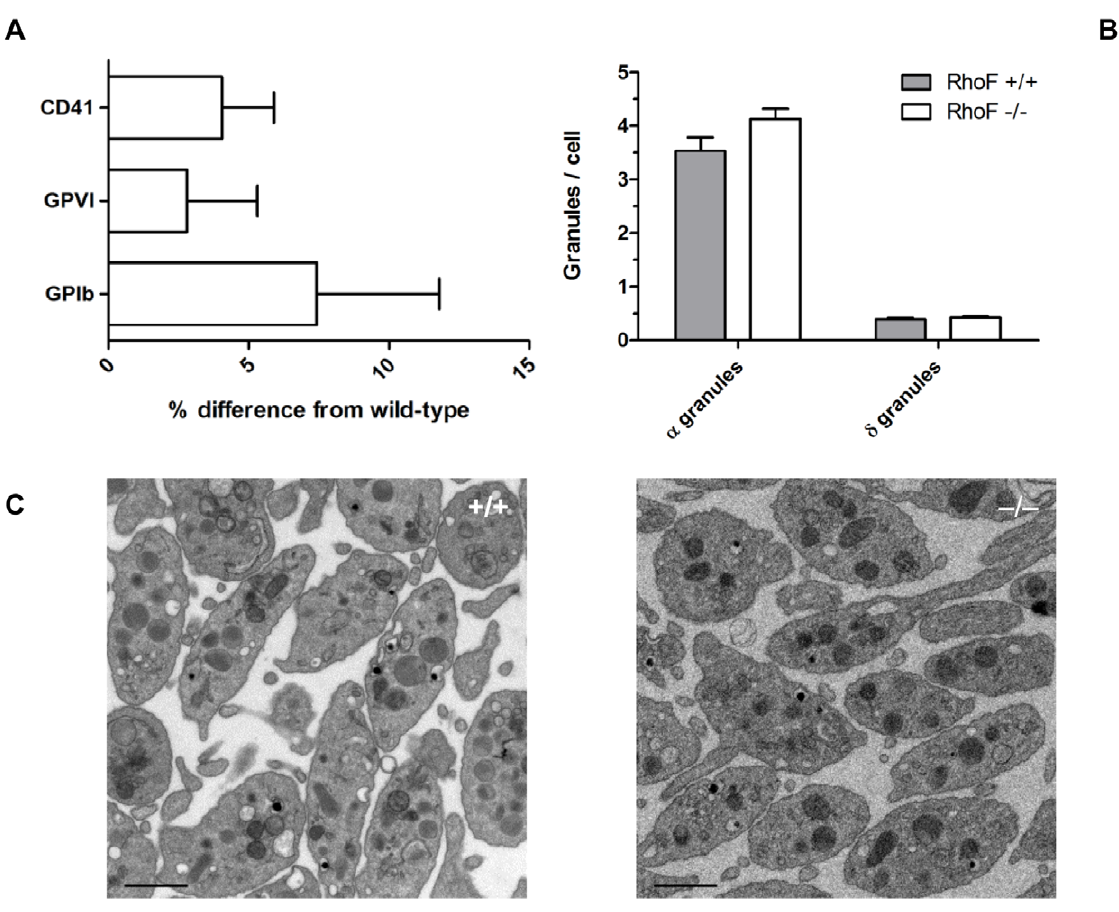
Figure 2. Platelets from RhoF 2 / 2 mice have normal surface glycoprotein expression, normal granule numbers and normal ultrastructure. ( A ) Expression of surface glycoproteins on RhoF 2 / 2 platelets was quantified by flow cytometry. Washed platelets were incubated with FITC labelled antibodies at saturating concentrations for 10 minutes at room temperature, then fixed and analysed by flow cytometry. Data are presented as mean 6 SEM of the percentage difference from wild-type controls (n=16). ( B ) Quantification of alpha and dense granule numbers per cell per thin section examined. Data are presented as mean 6 SEM of 3 mice per group. ( C ) Representative transmission electron microscopy images of resting wild-type and RhoF 2 / 2 platelets. Scale bars represent 1 m